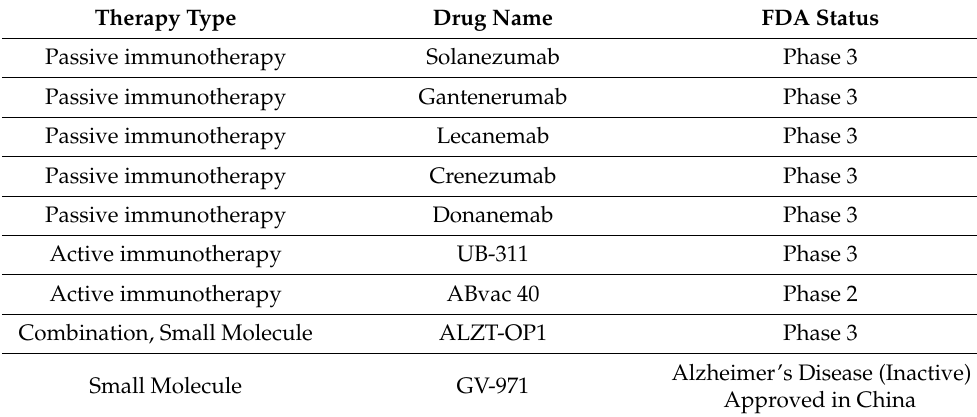
Table 2. Current amyloid-beta drugs of interest for